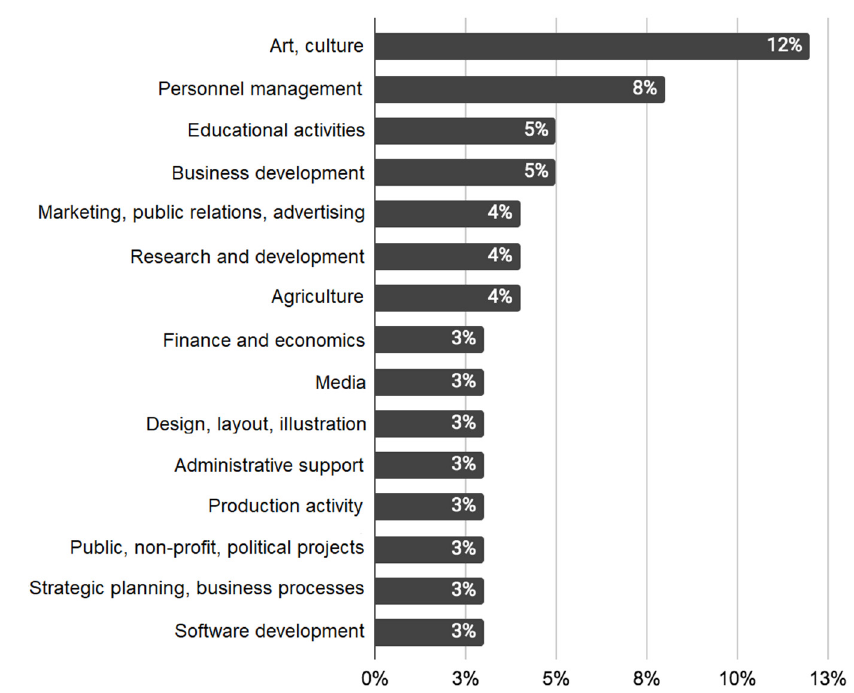
Figure 3. Answer of applicants to the question of which profession from which professional field they would change their current job (Compiled by the authors based on materials of Almanac HeadHunter (2017)).